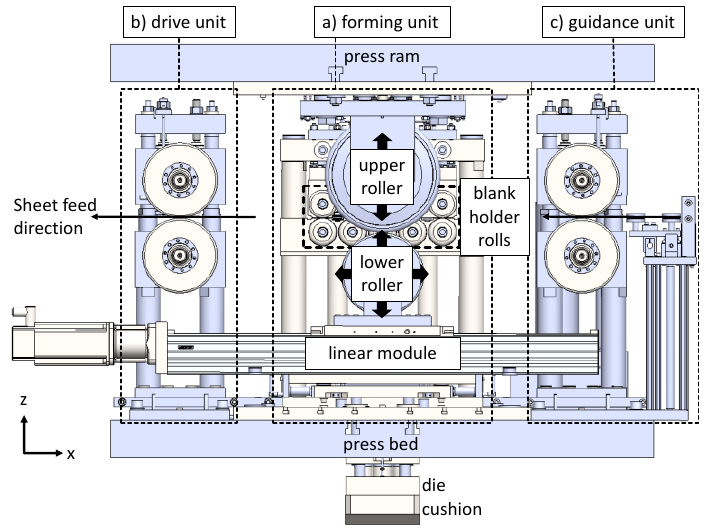
Figure 3. Flexible roller beading system.